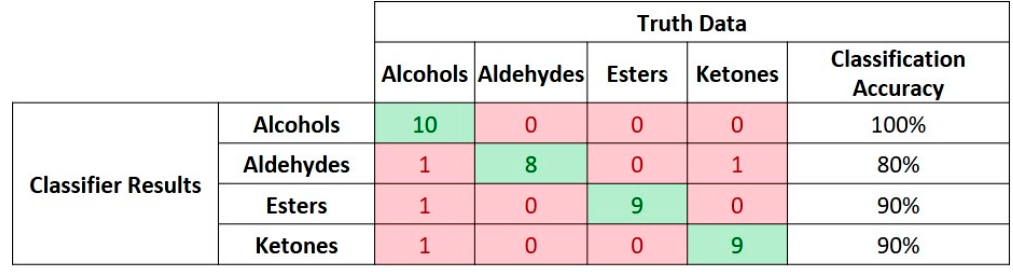
Figure 9. Confusion matrix for SNN-classifier results based on unseen samples for the 4-class dataset.